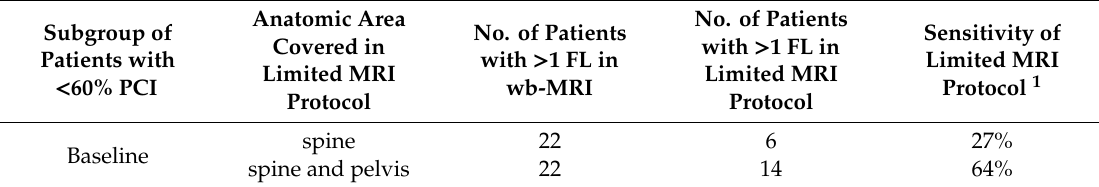
Table 2. Performance of limited MRI protocols in the subgroup of 118 patients with < 60% plasma cell